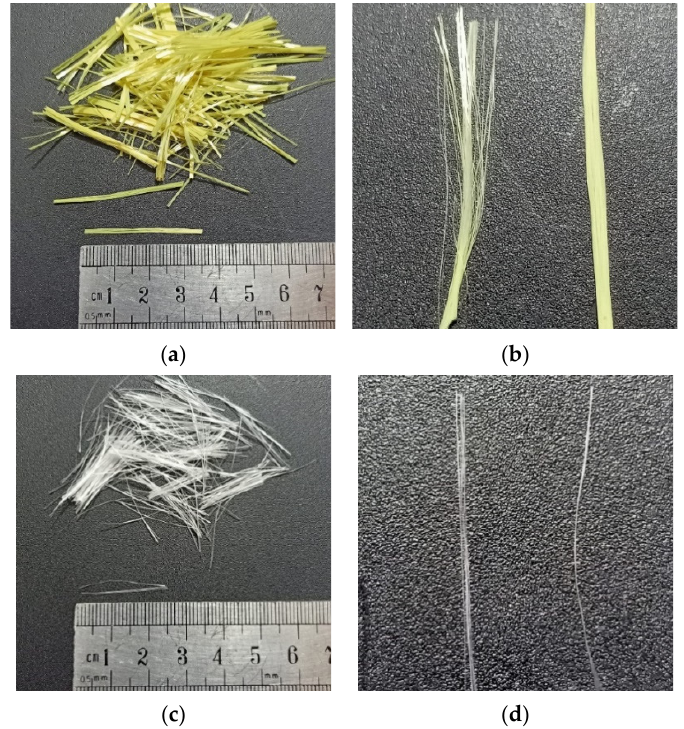
Figure 3. Fibers used in the study: ( a ) Kevlar fibers; ( b ) Kevlar bundles; ( c ) glass fibers; ( d ) glass bundles. Table 3. Physical and mechanical properties of fibers ( DuPont TM Kevlar ® 29 Aramid Fiber , n.d.; E-Glass Fiber, Generic , n.d.).